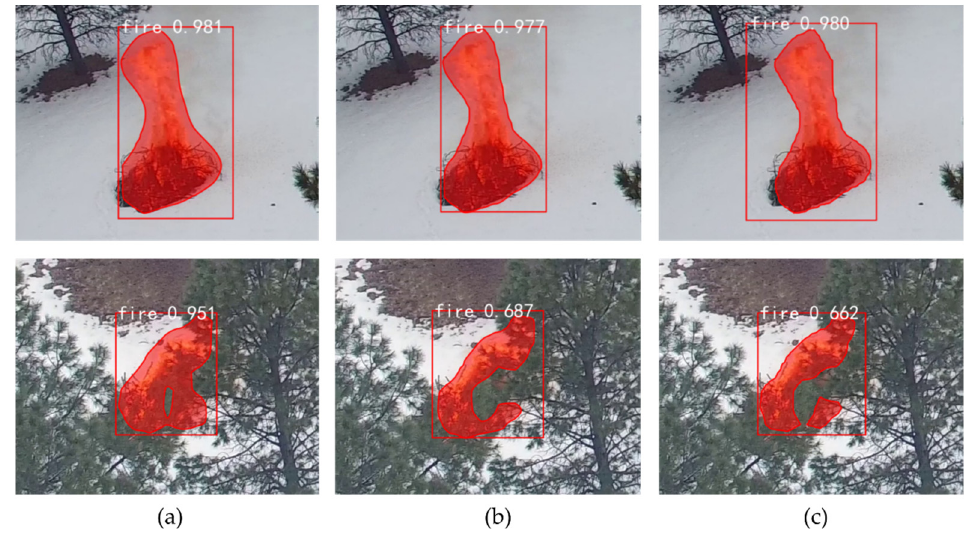
Figure 12. Local visualization and segmentation confidence: ( a ) mask R-CNN, ( b ) MS R-CNN, and ( c ) our MaskSU R-CNN.